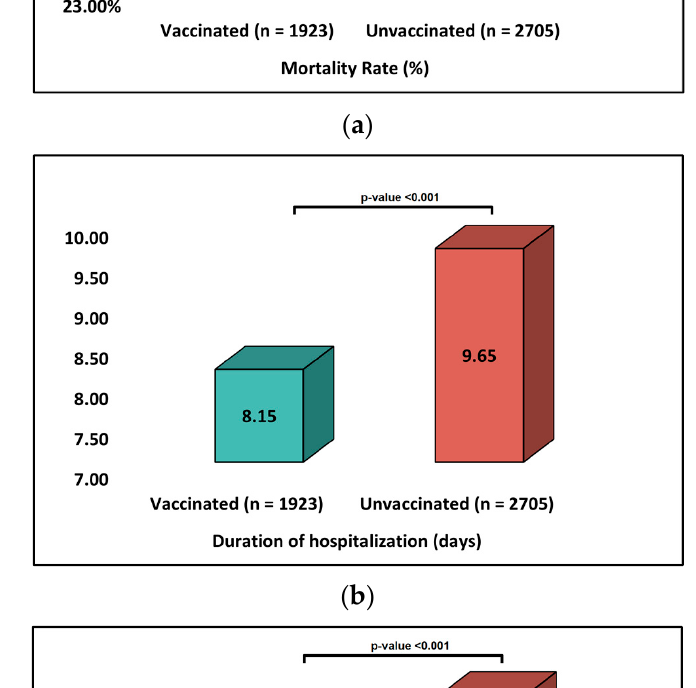
Table 3. Clinical outcomes by vaccination status.